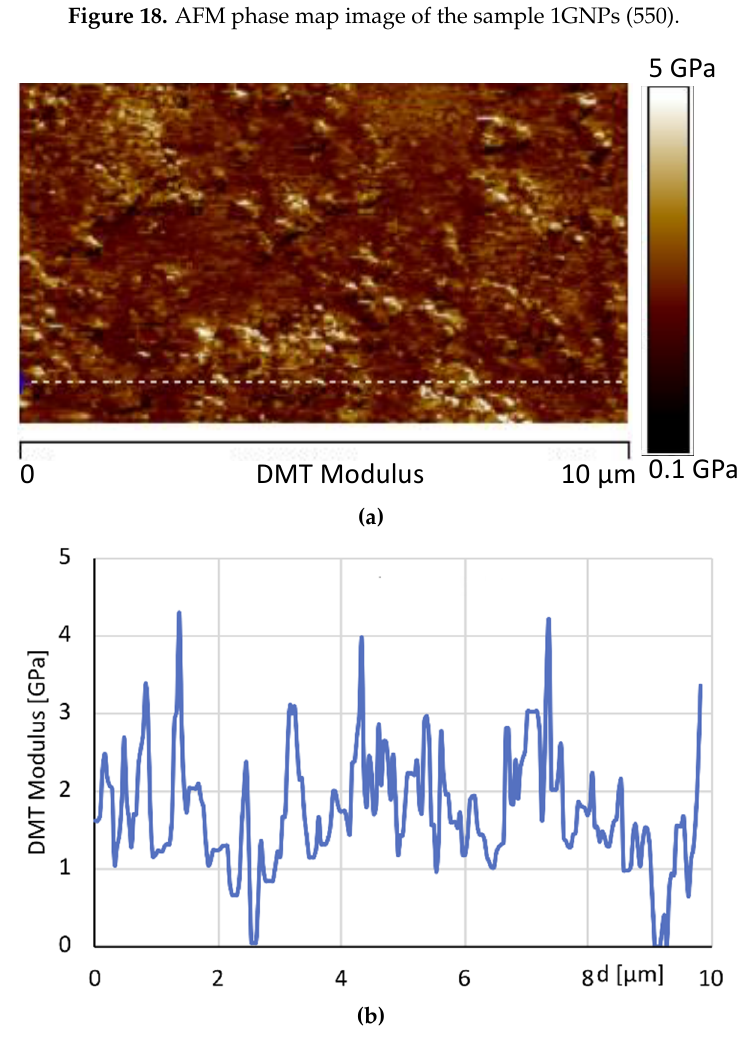
Figure 19. AFM image of the DMT modulus maps ( a ) with the profile of the value of the elastic modulus ( b ) of the same sample.